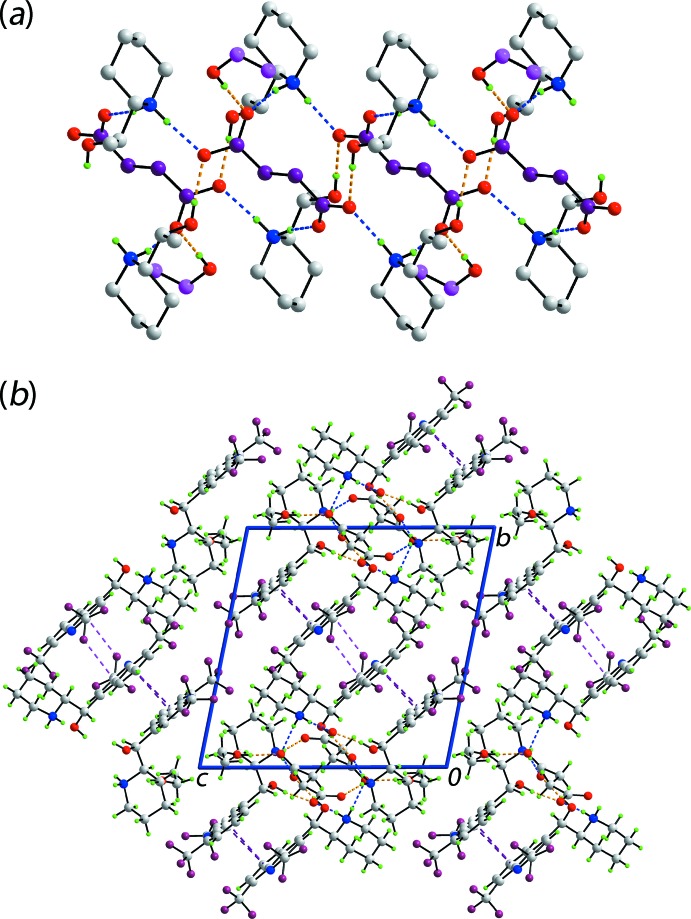
Mol­ecular packing in (I): (a) The supra­molecular chain along the a axis, being sustained by O—H⋯O (orange dashed lines) and N—H⋯O (blue dashed lines) hydrogen bonding with non-participating H atoms omitted and (b) a view of the unit-cell contents shown in projection down the a axis, the axis of propagation of the chain shown in (a). The C—Cl⋯π, and C—F⋯π inter­actions are shown as pink and purple dashed lines, respectively.